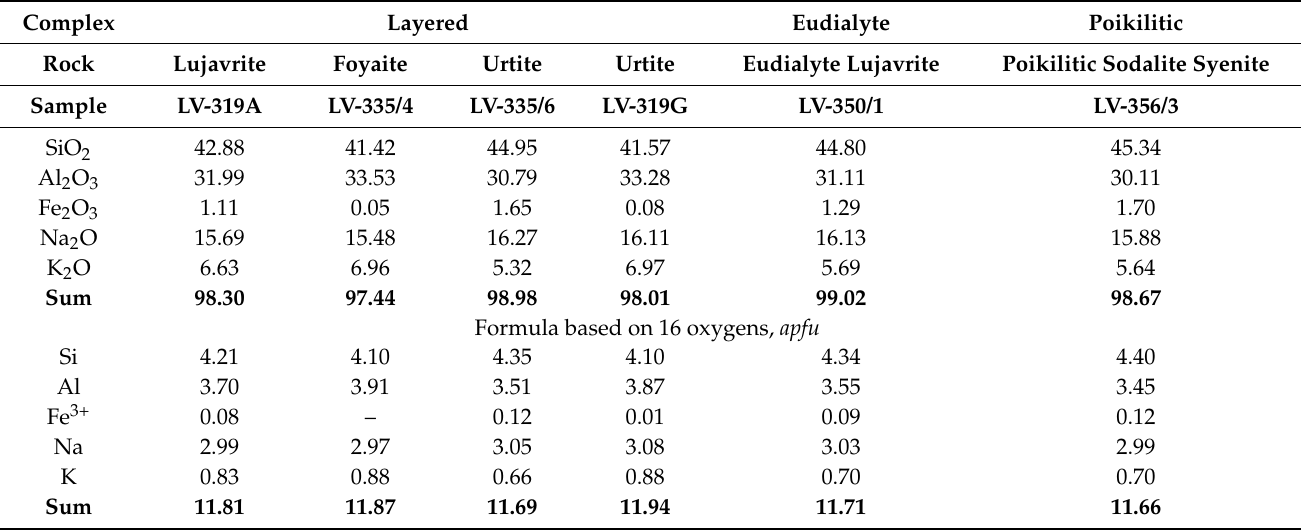
Table 4. Representative chemical analyses of nepheline from Lovozero rocks (microprobe, wt.%).